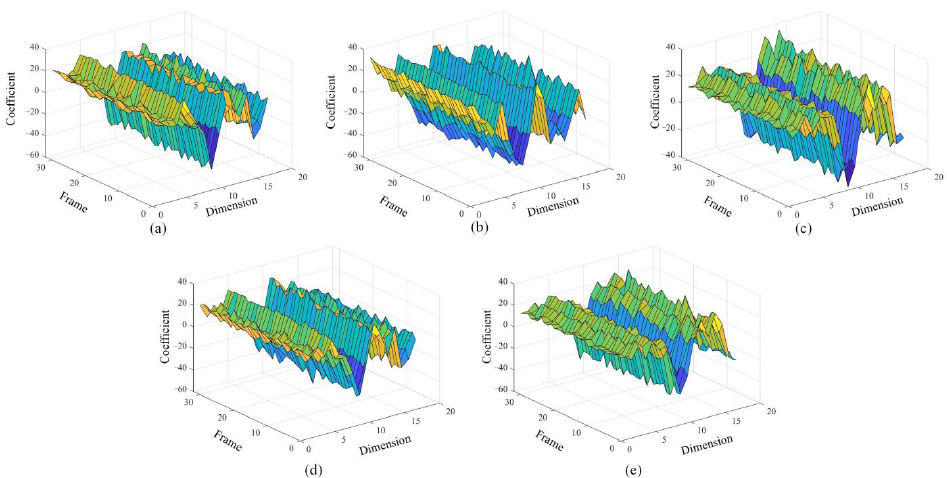
Figure 11. Comparison of VMMFCC characteristics in different states ( a ) normal state; ( b ) blocked air inlet; ( c ) the first cylinder misfire; ( d ) the third cylinder misfire; ( e ) the sixth cylinder misfire.